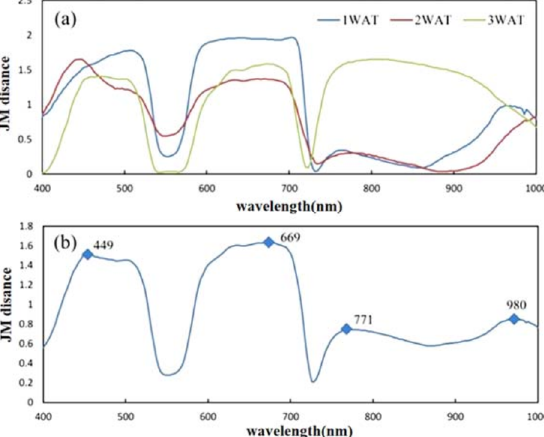
Figure 6. Sensitivity of bands to the recoverability of the glyphosate-treated corn plants: ( a ) Jeffries– Matusita (JM) distance curves between the recoverable (0.01X–0.2X) and unrecoverable (0.5X–1.0X) samples at 1 WAT, 2 WAT, and 3 WAT; ( b ) bands marked at the curve peaks of the averaged JM distance